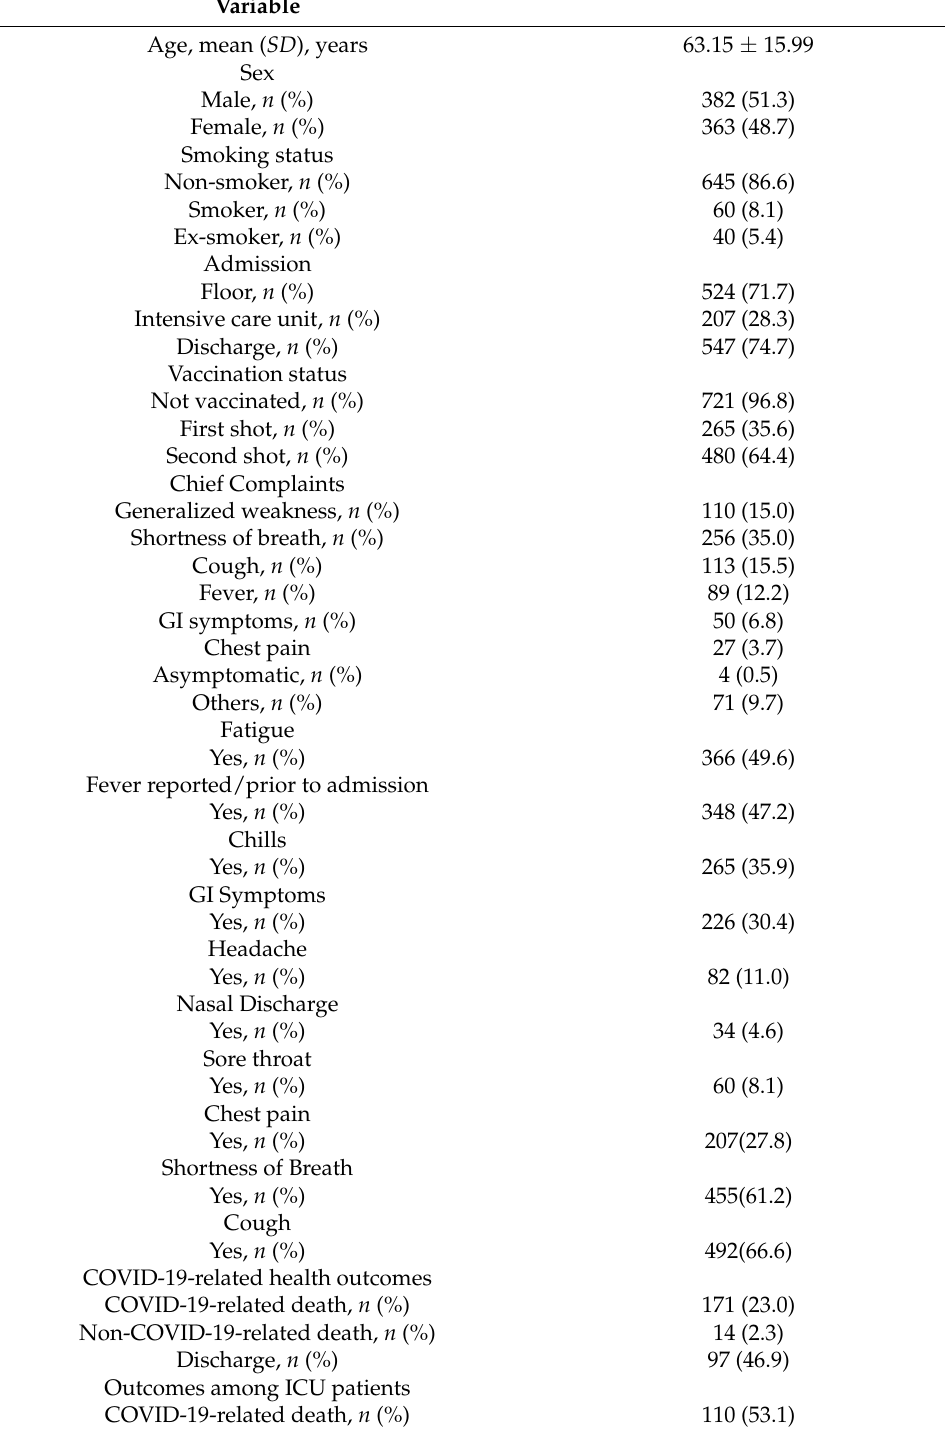
Table 1. Demographics of admitted COVID-19 patients ( n =